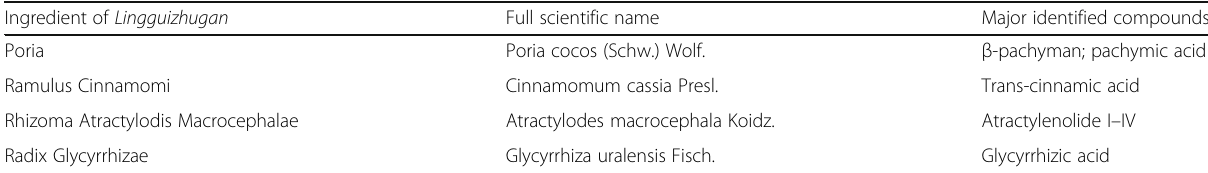
Table 1 Full names of the ingredients of